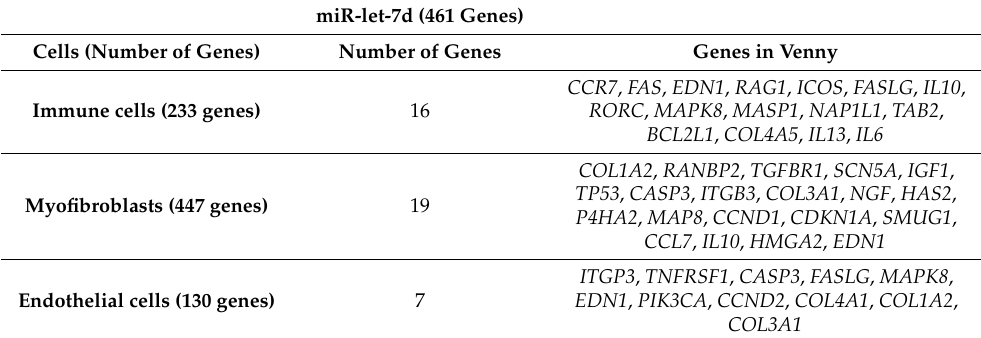
Table 4. Genes controlled by miR-let-7d and involved in the biology of immune, myofibroblast and endothelial cells.